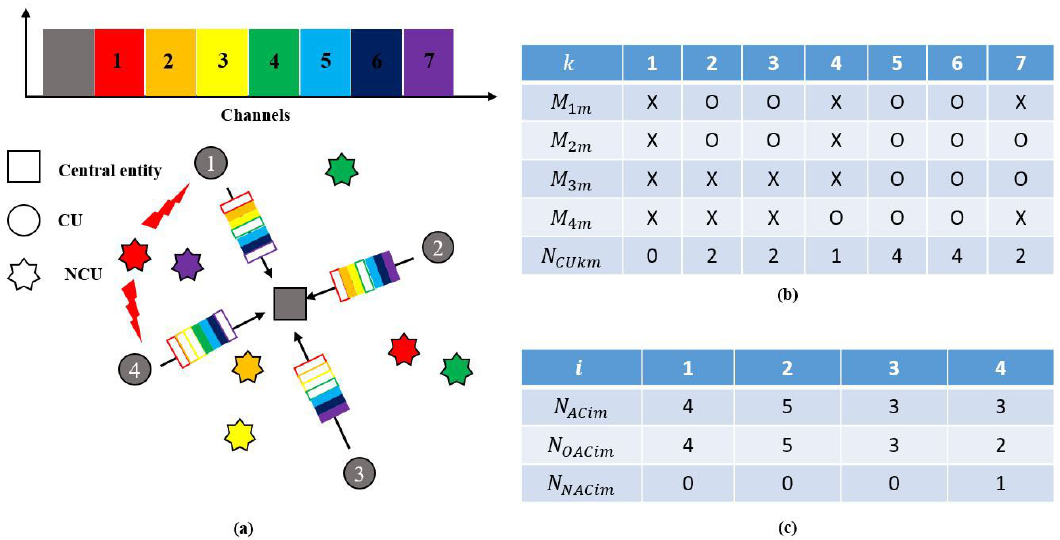
Figure 4. An example of the asymmetry of available channels in a centralized UCAN: ( a ) network configurations and channel description; ( b ) the results of M im and N CUkmx ; ( c ) the results of N ACim , N NACim , and N OACim , and . 𝑁𝑁 𝑁𝑁𝑀𝑀𝑁𝑁𝑖𝑖𝑚𝑚 𝑁𝑁 𝑂𝑂𝑀𝑀𝑁𝑁𝑖𝑖𝑚𝑚